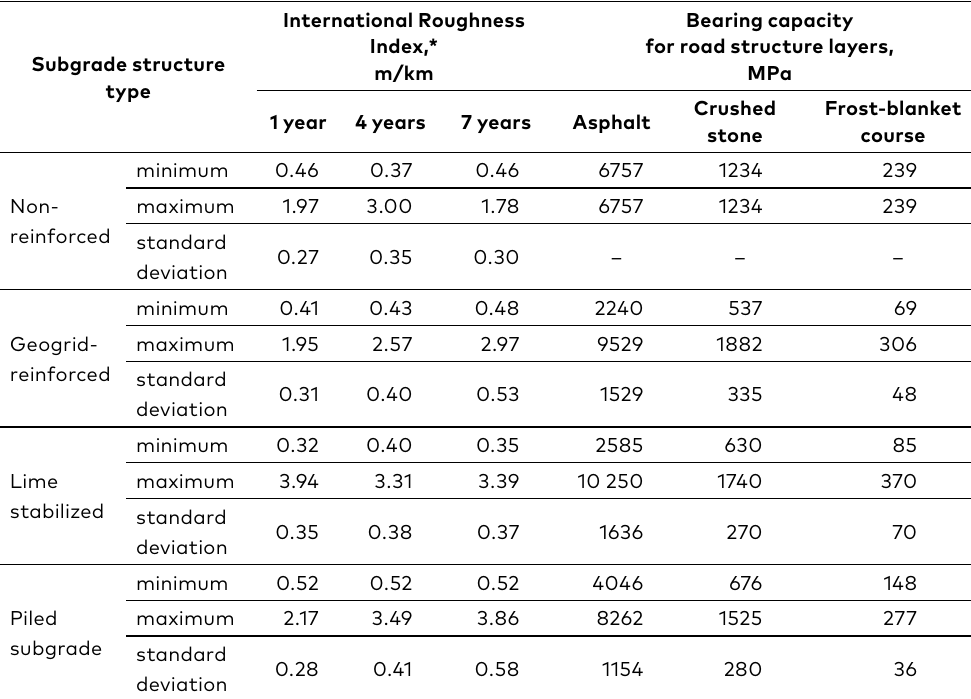
Table 3. Statistical values by the type of subgrade structure of